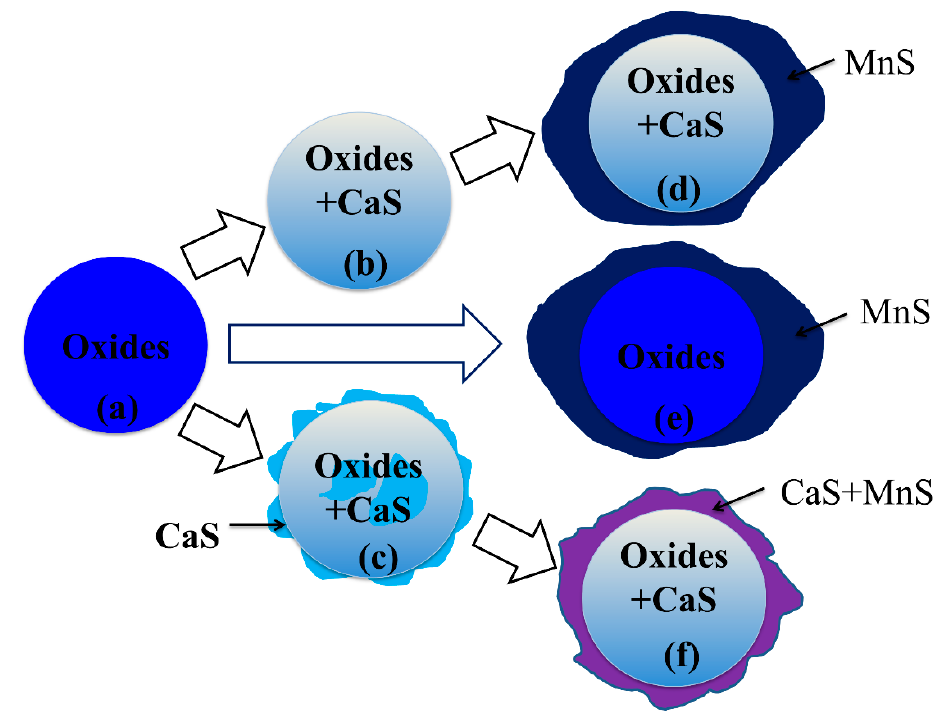
Figure 10. Schematic diagram for formation mechanism of Type-1 and 3 inclusions.